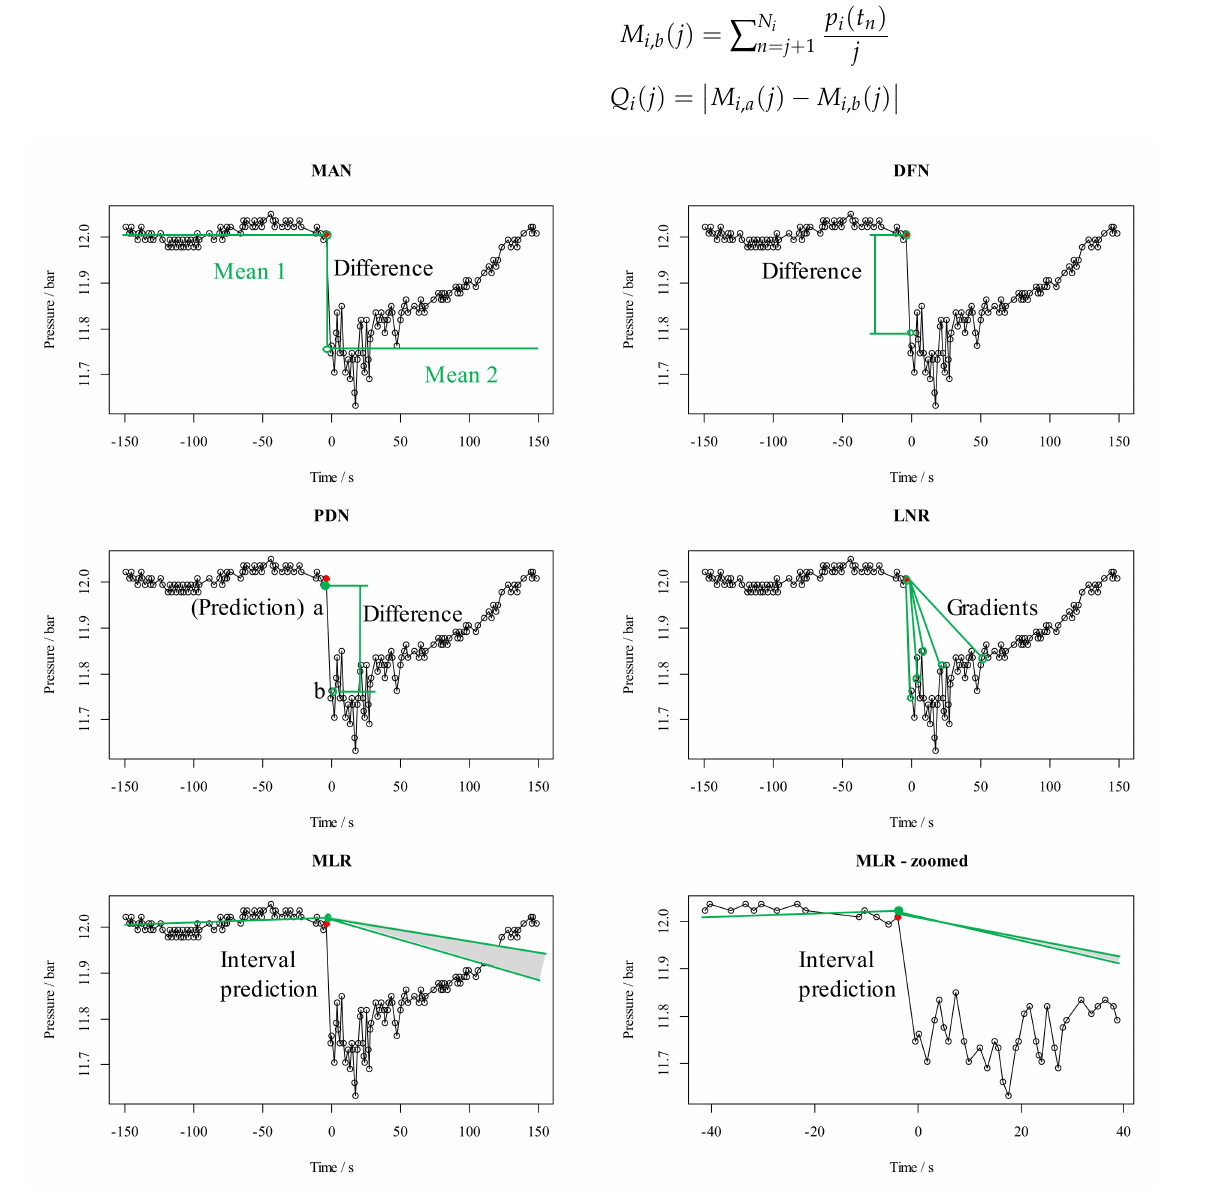
Figure 4. Explanation of the five self-developed algorithms − MAN ( top left ), DFN ( top right ), PDN ( middle left ), LNR ( middle right ), MLR ( bottom left ), and MLR zoomed ( bottom right ). The second algorithm was the difference algorithm (DFN algorithm, cp. Figure 4, top right). With this algorithm, the maximum difference D i of each pressure curve between the value of data point ( j − 1 ) and the value of data point ( j + 1 ) was searched. If the maximum absolute difference of each pressure curve was found, the value and time of each pressure signal could be determined. The data point with the maximum absolute difference D i was the PDTP, and Equation (4) was applied: